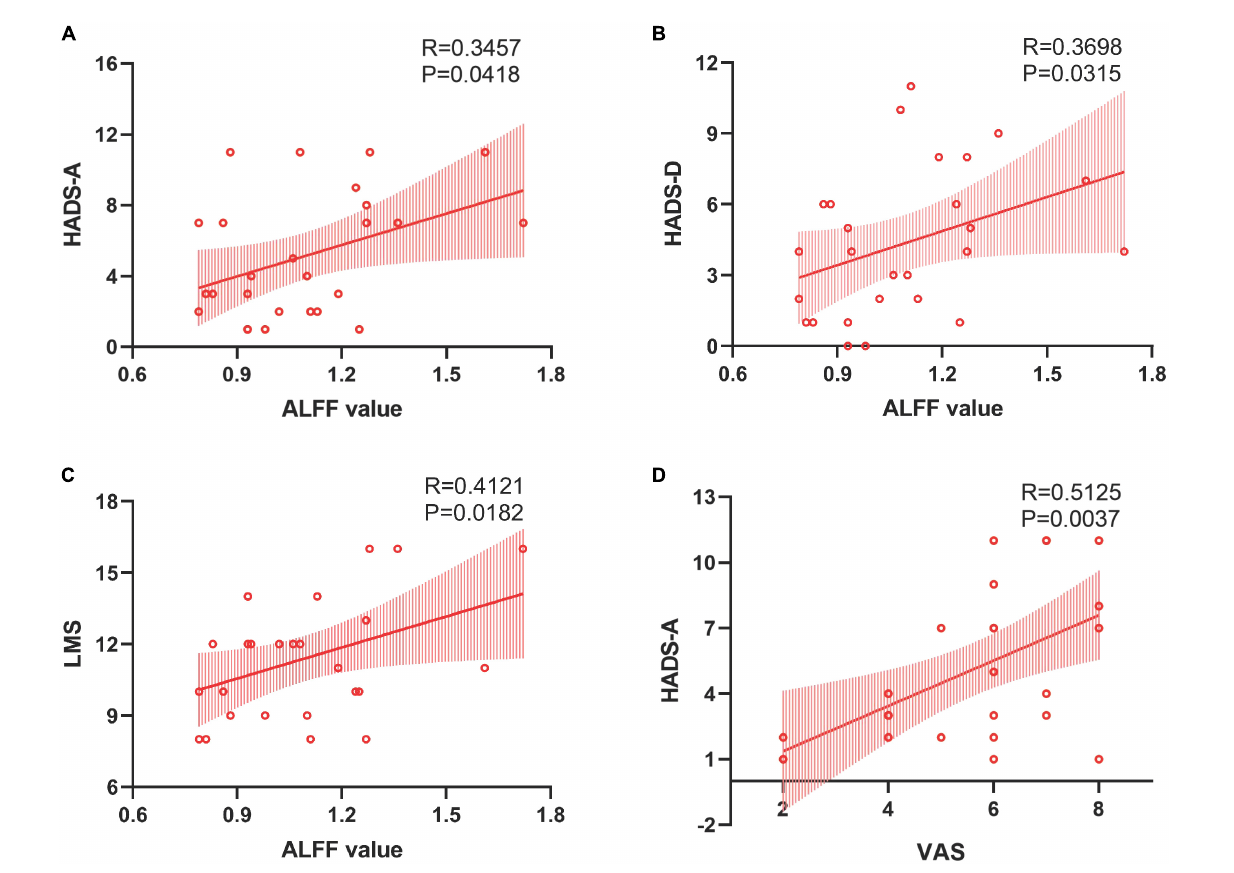
FIGURE3 Correlations between the ALFF value in the left orbital SFC and clinical assessment. Panels (A,B) revealed positive correlations between ALFF in the left orbital SFC and HADS-A and HADS-D scores. Panel (C) established a “dose-dependent” association between the ALFF value in the left orbital SFC and the objective severity of inflammation. Panel (D) showed a positive correlation between the patient’s subjective severity of inflammation and anxiety scores. SFC, superior frontal cortex; HADS-A, hospital anxiety and depression scale-anxiety; HADS-D, hospital anxiety and depression scale-depression; LMS, Lund-Mackay scoring.